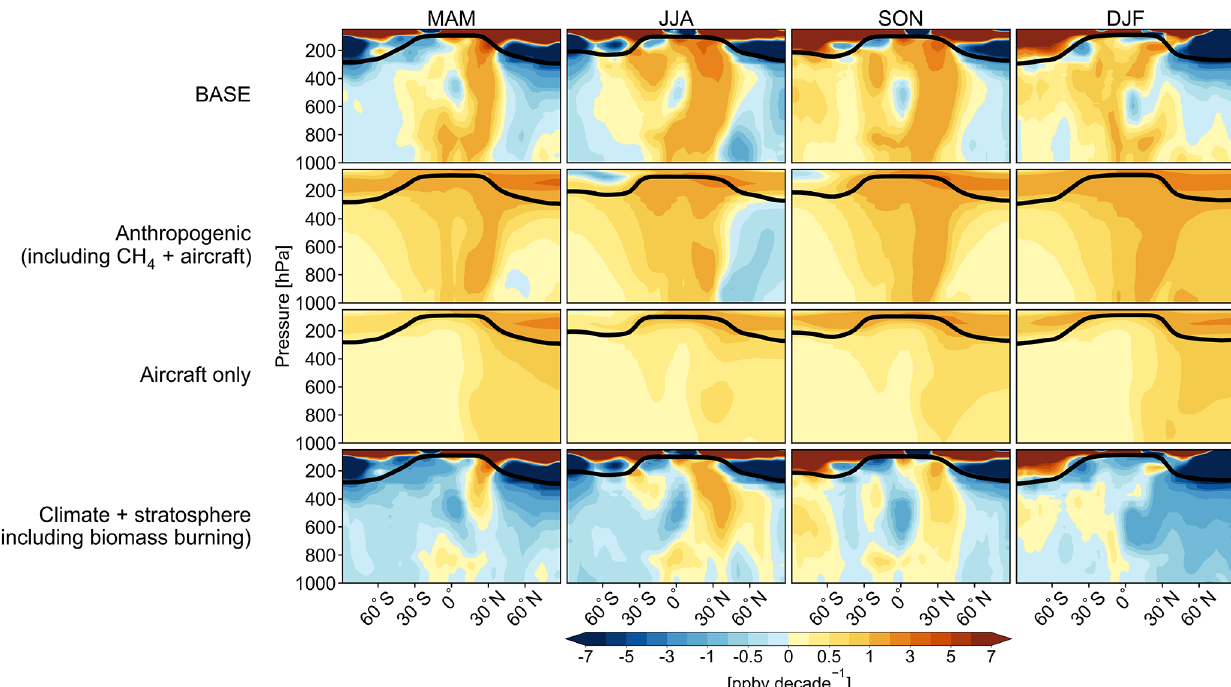
Figure 10. Drivers of seasonal zonal-mean ozone trends from 1995 to 2017 estimated in the GEOS-Chem model. Trends contributed by changes in anthropogenic emissions (surface emissions, aircraft emissions, and methane), aircraft emissions alone, and climatic and strato- spheric factors are estimated. Black lines represent the 1995–2017 climatological seasonal mean tropopause from the MERRA-2 reanalysis dataset. MAM: March–April–May, JJA: June–July–August, SON: September–October–November, DJF: